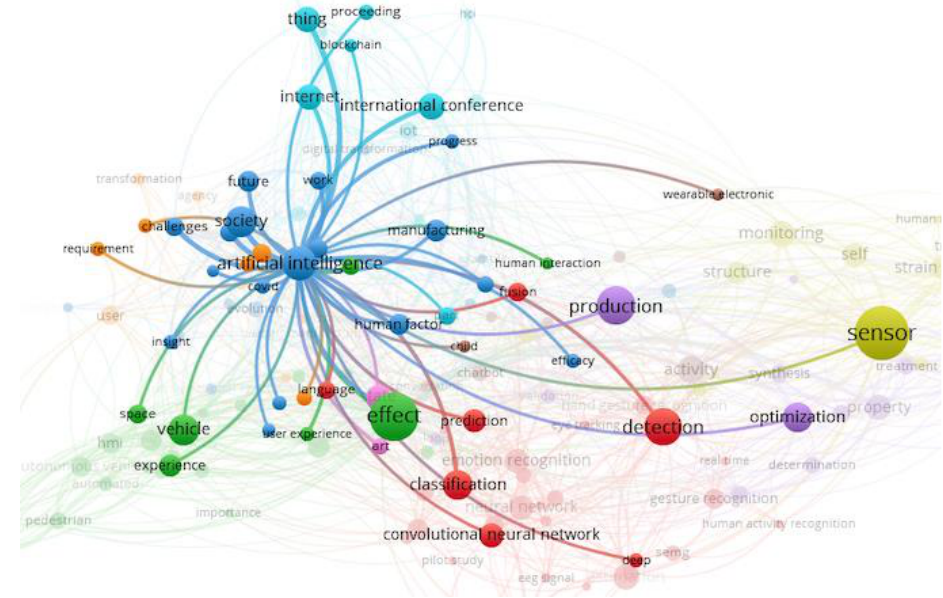
Figure 20. Artificial intelligence dependency.